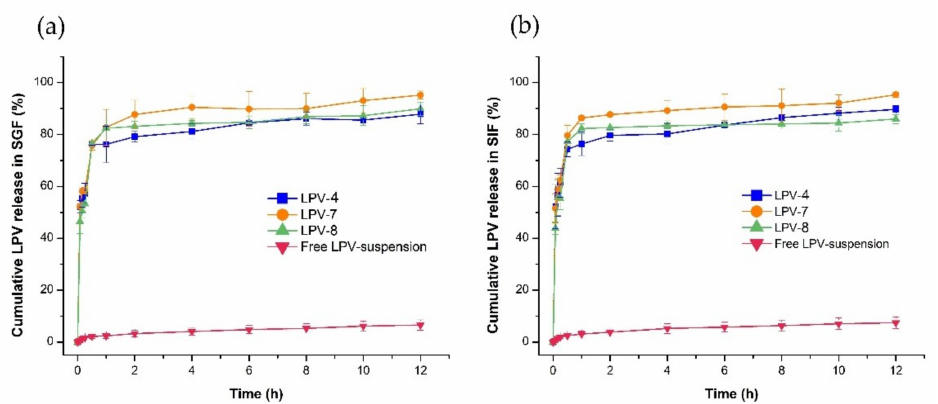
Figure 4. Comparison of LPV release from LPV-NLC-4-Tres, LPV-NLC-7-Tres, LPV-NLC-8-Tres, and LPV -suspension for 12 h in ( a ) SGF (pH 1.2) and ( b ) SIF (pH 6.8) media. Mean ± S.D, n =